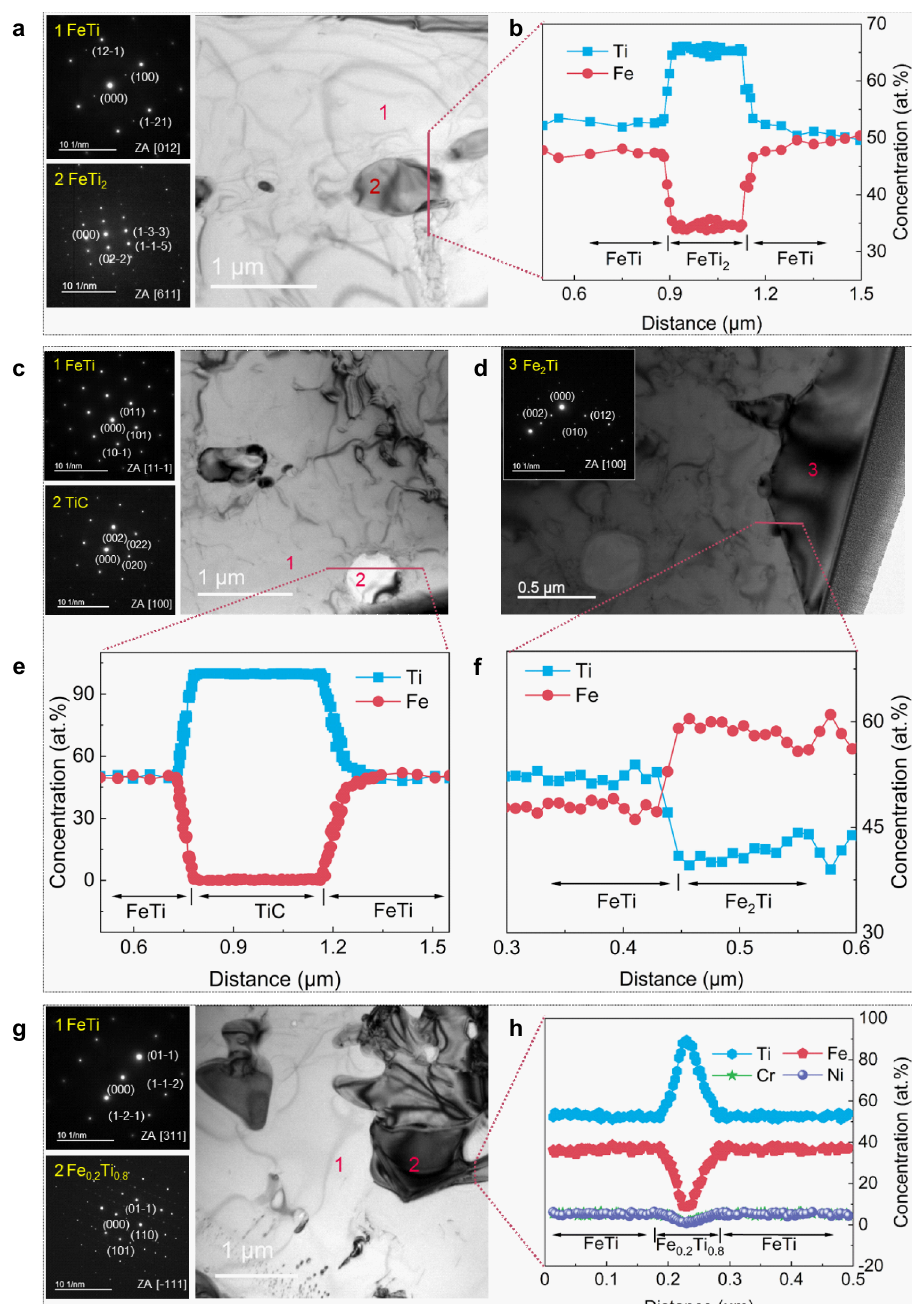
Fig. 2 TEM results of as-cast pure FeTi, C45-Gr2 FeTi, and 316L-Gr2 FeTi alloys. a Bright- fi eld image and corresponding SAED images, and b line EDX results of pure FeTi. c , d Bright- fi eld image, and corresponding SAED images, and e , f Line EDX results of C45-Gr2 FeTi. g Bright- fi eld image and corresponding SAED images, and h Line EDX results of 316L-Gr2